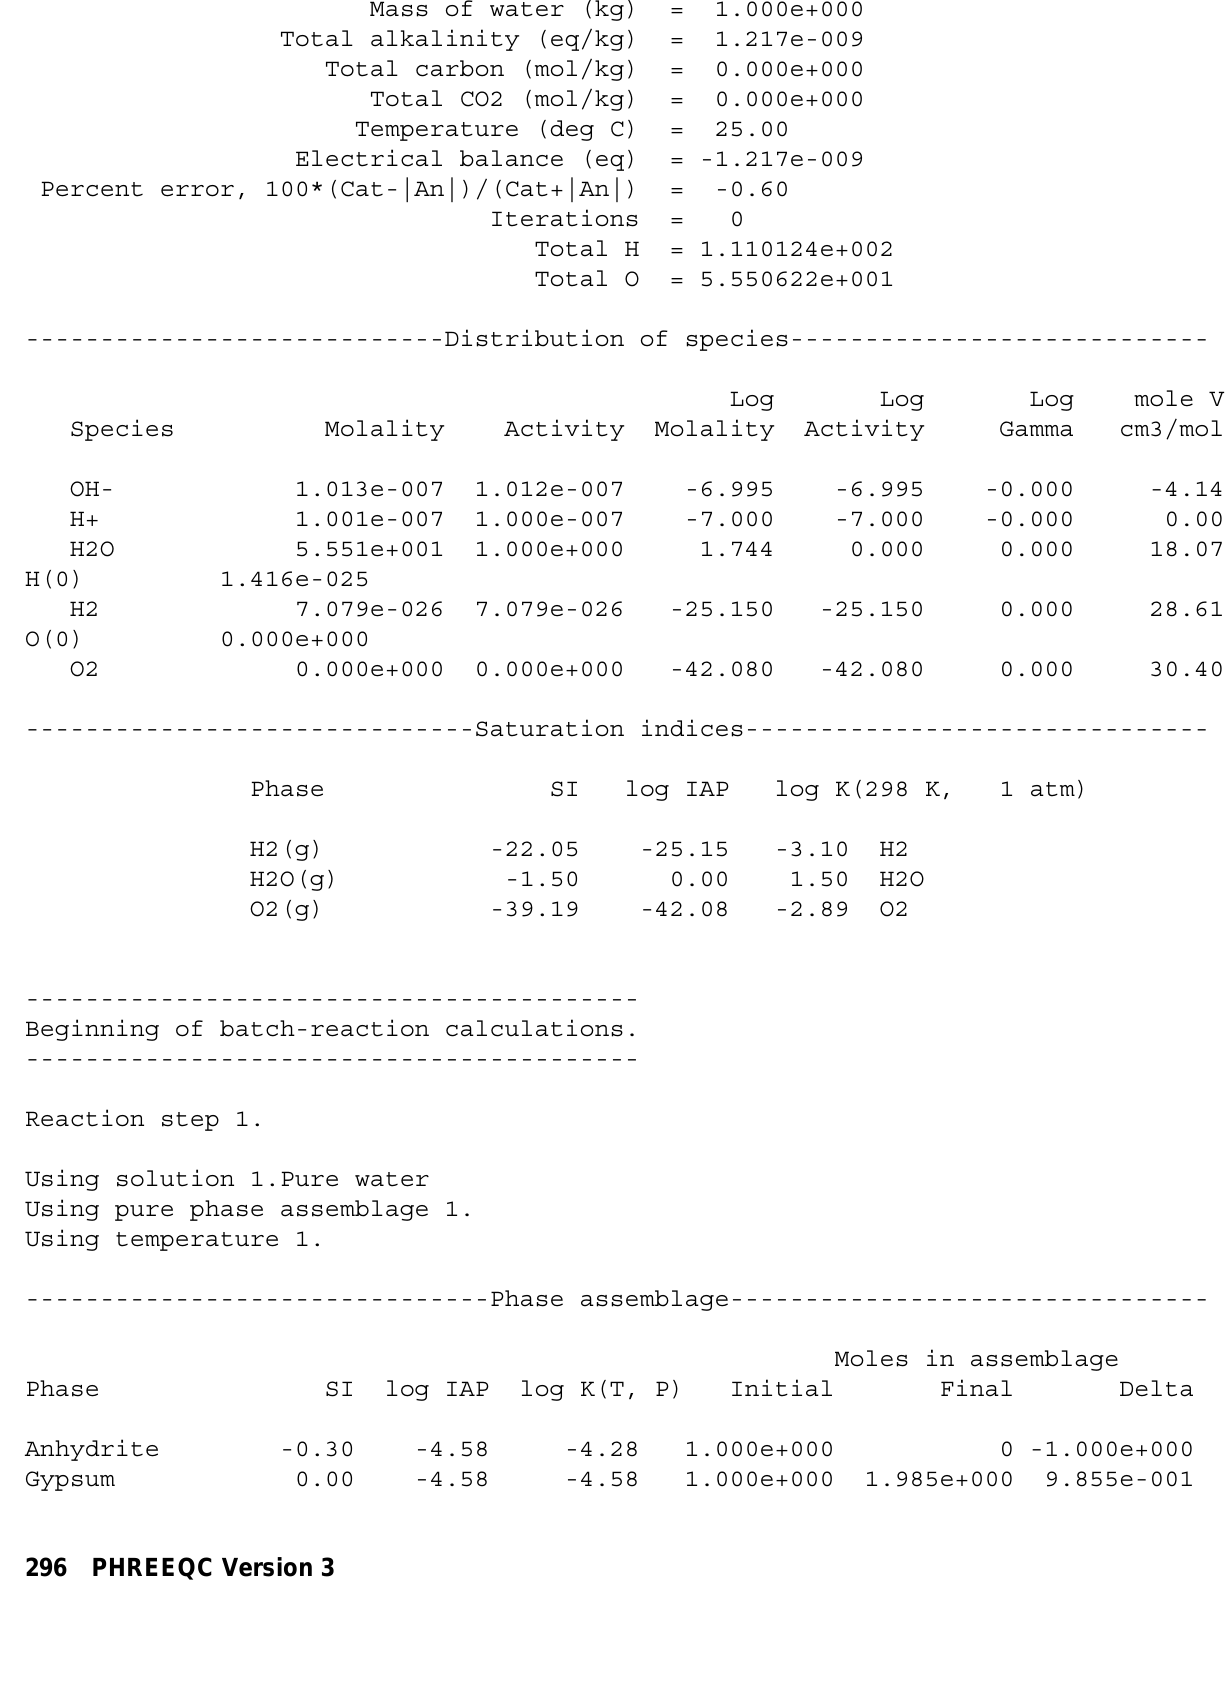
Table 13. Selected output for example 2.—Continued Activity of water = 1.000 Ionic